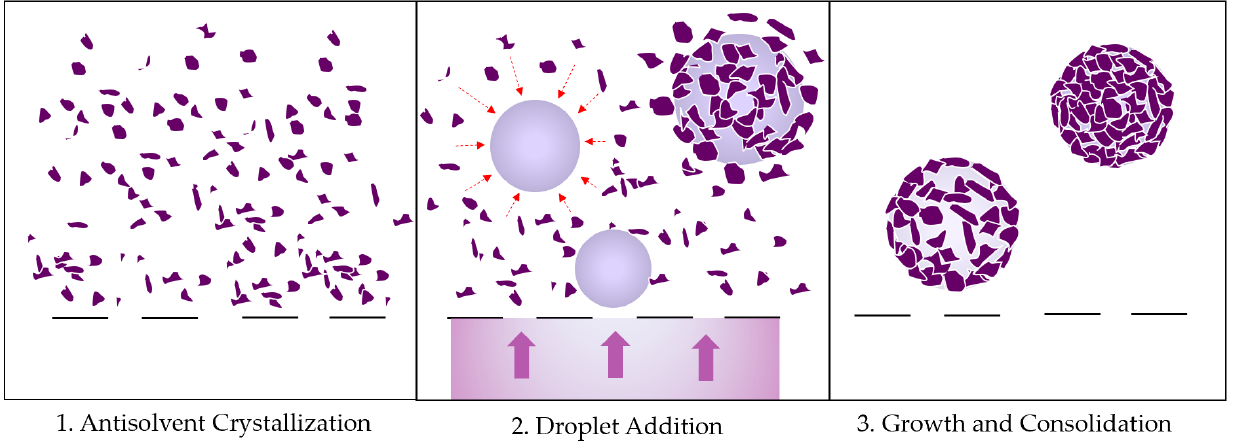
Figure 2. Spherical agglomeration steps: 1. API dissolved in solvent added to antisolvent to create supersaturation and cause nucleation and growth of crystals. 2. Bridging liquid droplets are introduced through the membrane to allow for crystals to adsorb onto the droplet surface. 3. Droplet addition ends, and spherical agglomerates are still mixed to allow for consolidation and growth of agglomerates.